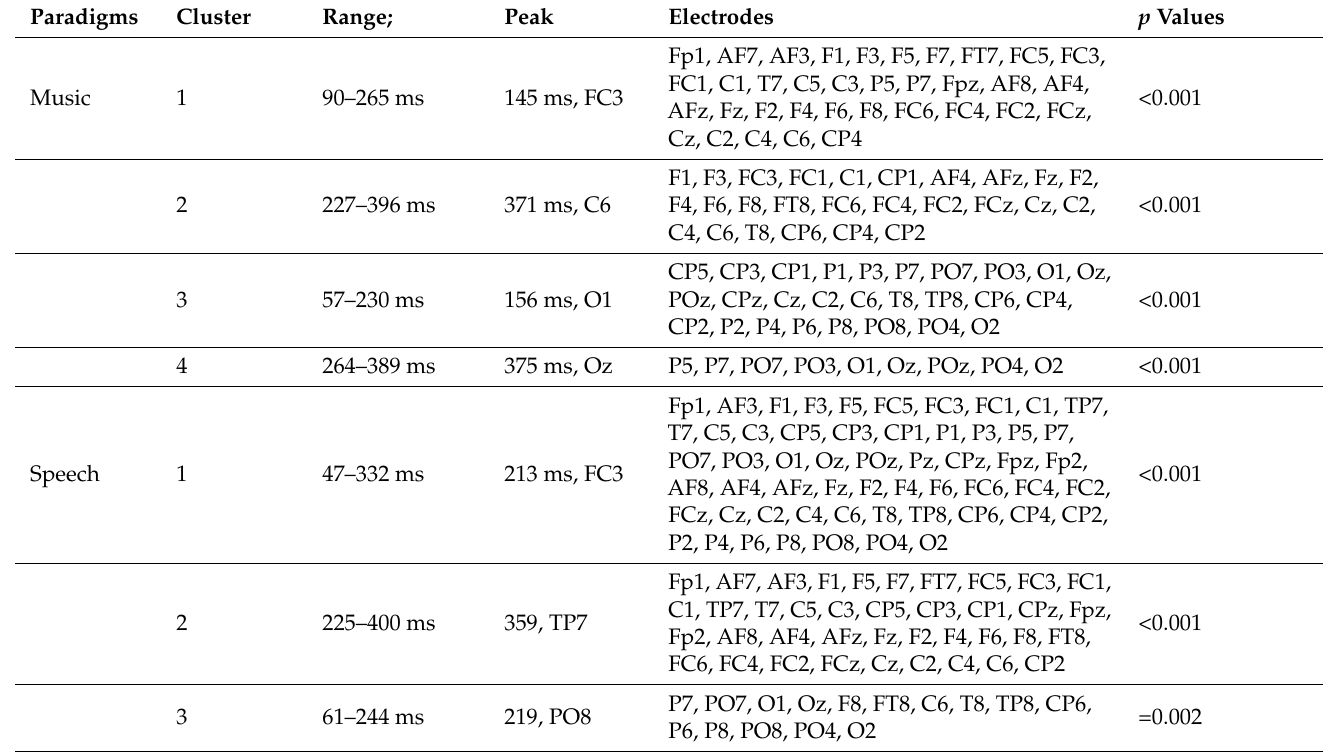
Table 2. Results from the clustered-statistic comparing auditory evoked responses elicited by deviant and standard stimuli from the music and speech oddball paradigm before the